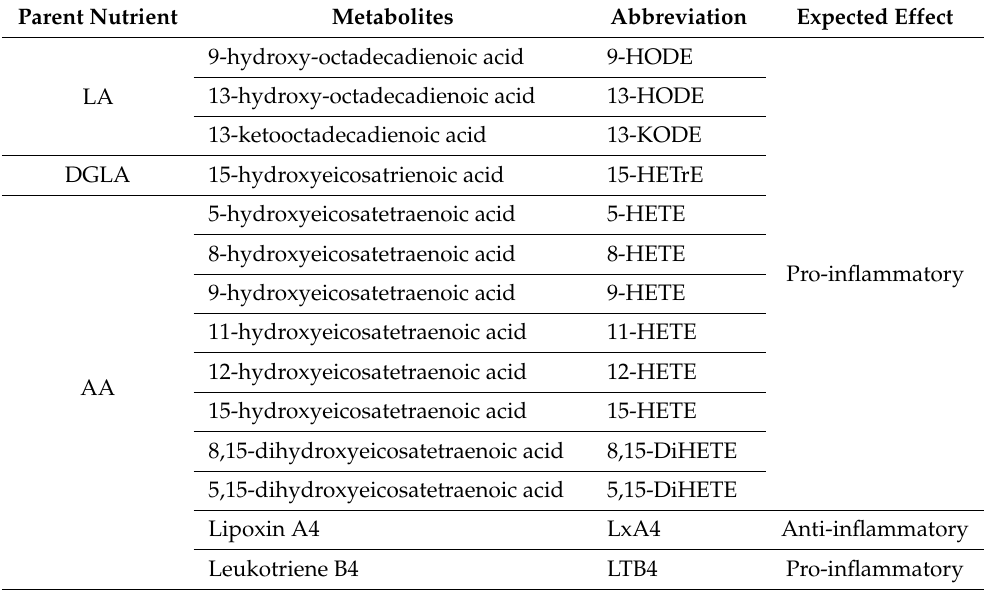
Table 13. n-6 FA metabolites and